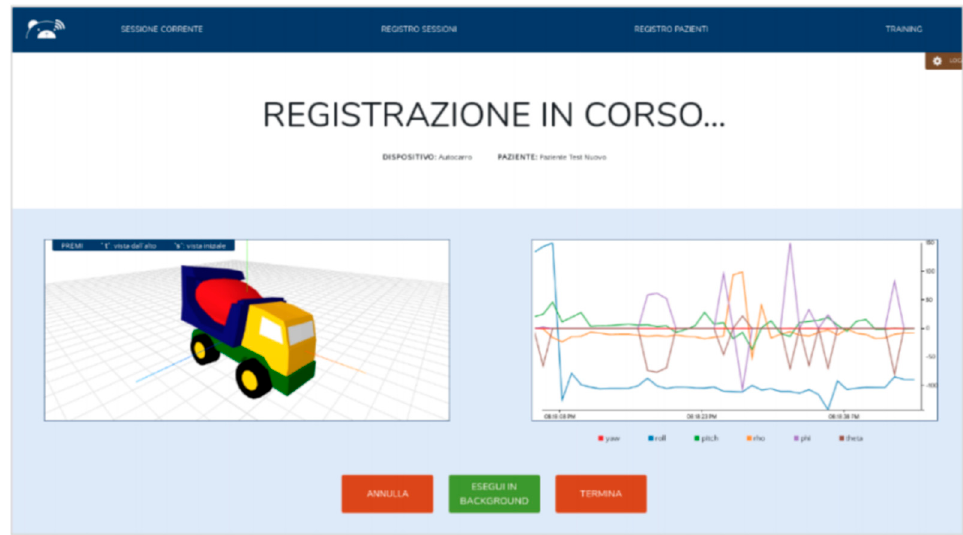
Figure 7. Monitoring a recording session.